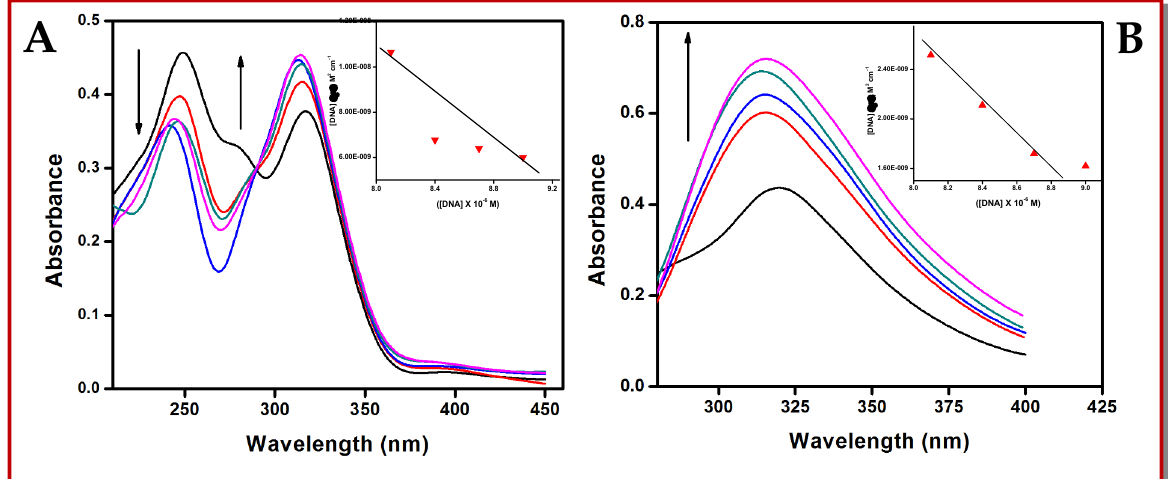
Figure 1: UV-Vis. absorption spectra of compound 3a (A) or 3b (B) (Black) in the presence of increasing amount of Ct-DNA. The inset is plot of DNA concentration/ ( (cid:454) a - (cid:454) f ) vs DNA concentration for the titration of DNA to compound ( 3a )